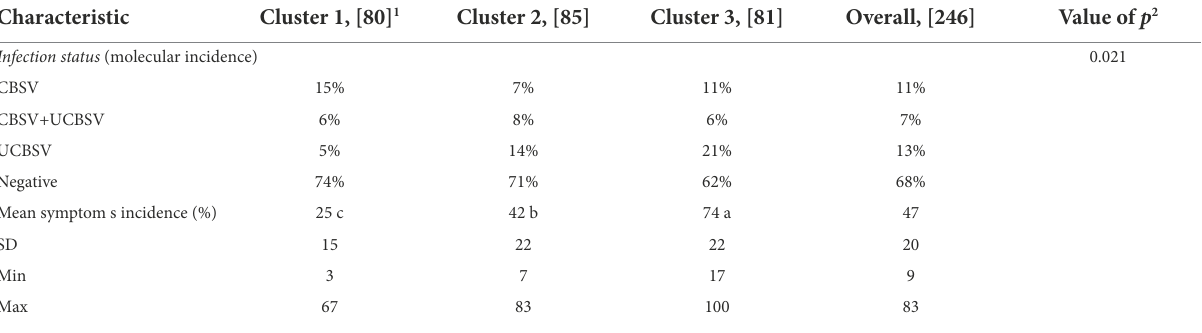
TABLE 5 Percentages of CBSVs detection and of symptom incidence according to clusters of the study